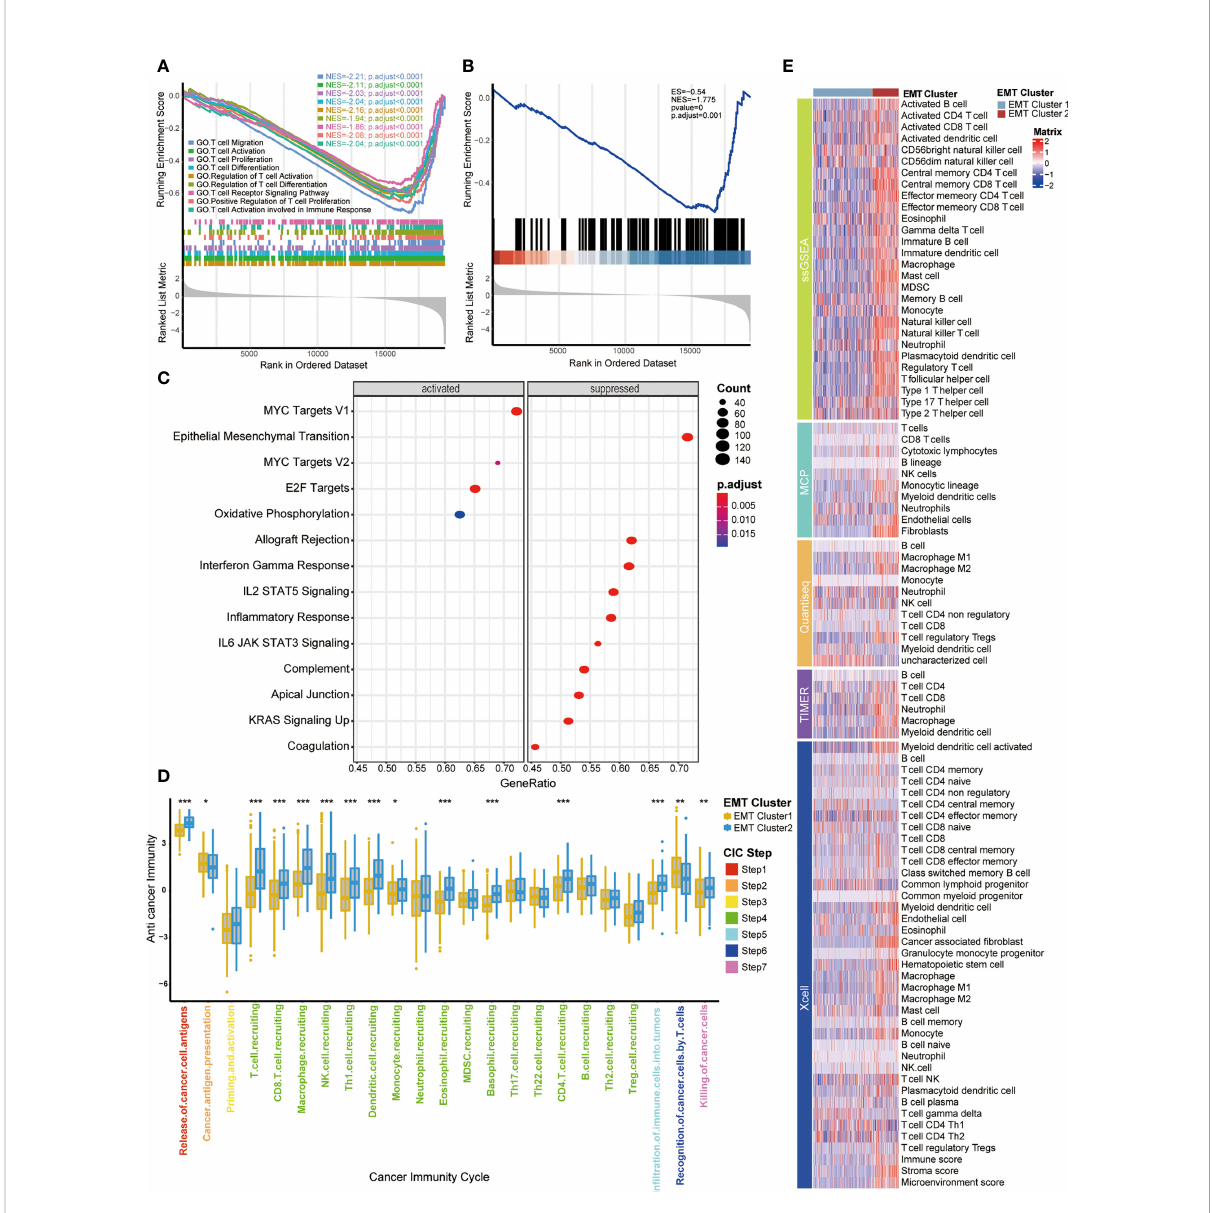
FIGURE 2 Functional analysis of EMT-related patterns and association with TIME (A, B) GSEA enrichment analysis of the status of KEGG and GO pathways in two EMT Cluster groups; EMT Cluster1 vs EMT Cluster2. (C) The difference on the hallmark gene sets between two EMT Cluster groups; EMT Cluster1 vs EMT Cluster2. (D) The different levels of anti-cancer immunity between two EMT-based patterns; Yellow and Blue lines represented EMT cluster 1 and 2, separately. *P < 0.05; **P < 0.01; ***P < 0.001; ns, not statistically signi fi cant. (E) Describe the difference of immune cell in fi ltration in TME between two EMT related patterns using fi ve different algorithms, including ssGSEA, MCP, Quantiseq, TIMER and Xcell; Dark purple and light purple lines represented TNF cluster 1 and 2,